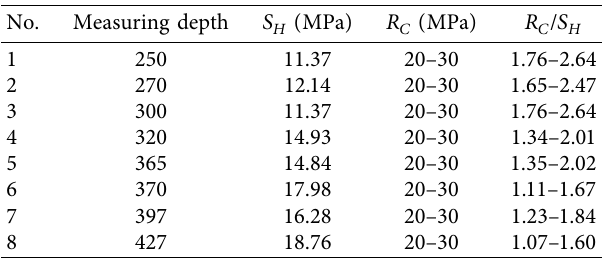
Figure 1: Location of the Muzhailing Tunnel and the no. 2 inclined shaft. Table 1: Ratio of crustal stress to R c in the Muzhailing Tunnel area. No. Measuring